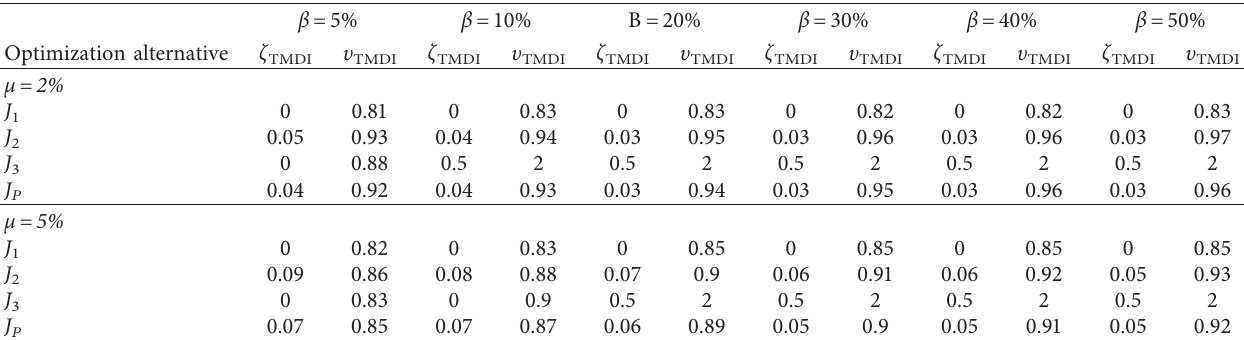
Table 8: TMDI optimization parameters for µ � 0.02 and µ � 0.05 for the structure subjected to the “ Christchurch ” record.